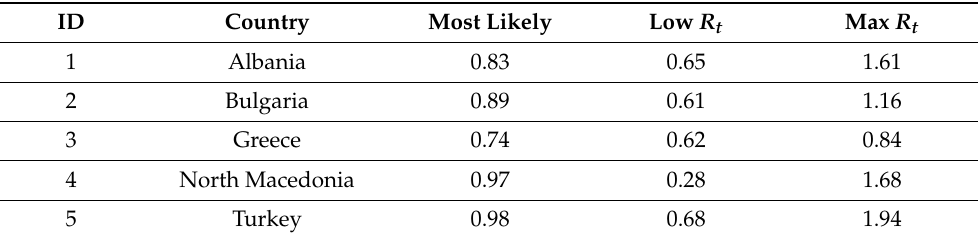
Table 5. Most likely value of R t along with its highest density